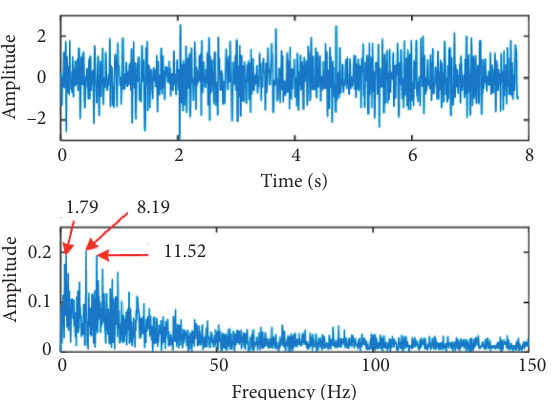
Figure 6: Time-domain waveform and envelope spectrum of the reconstructed